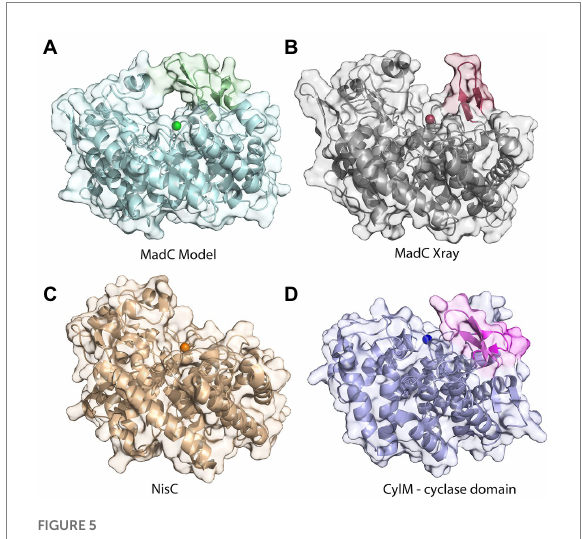
FIGURE 6 AlphaFold2 models of class I cyclases. (A) Class I cyclase MadC from Clostridium maddingley. The new features are colored in red. (B) Class I cyclase GeoC from Geobacillus thermodenitrificans. The new predicted features are in pink. (C) Class I cyclase SpaC from Bacillus subtilis. The new features are colored in yellow. (D) Class I cyclase EpiC from Staphylococcus epidermidis. The new feature is colored in